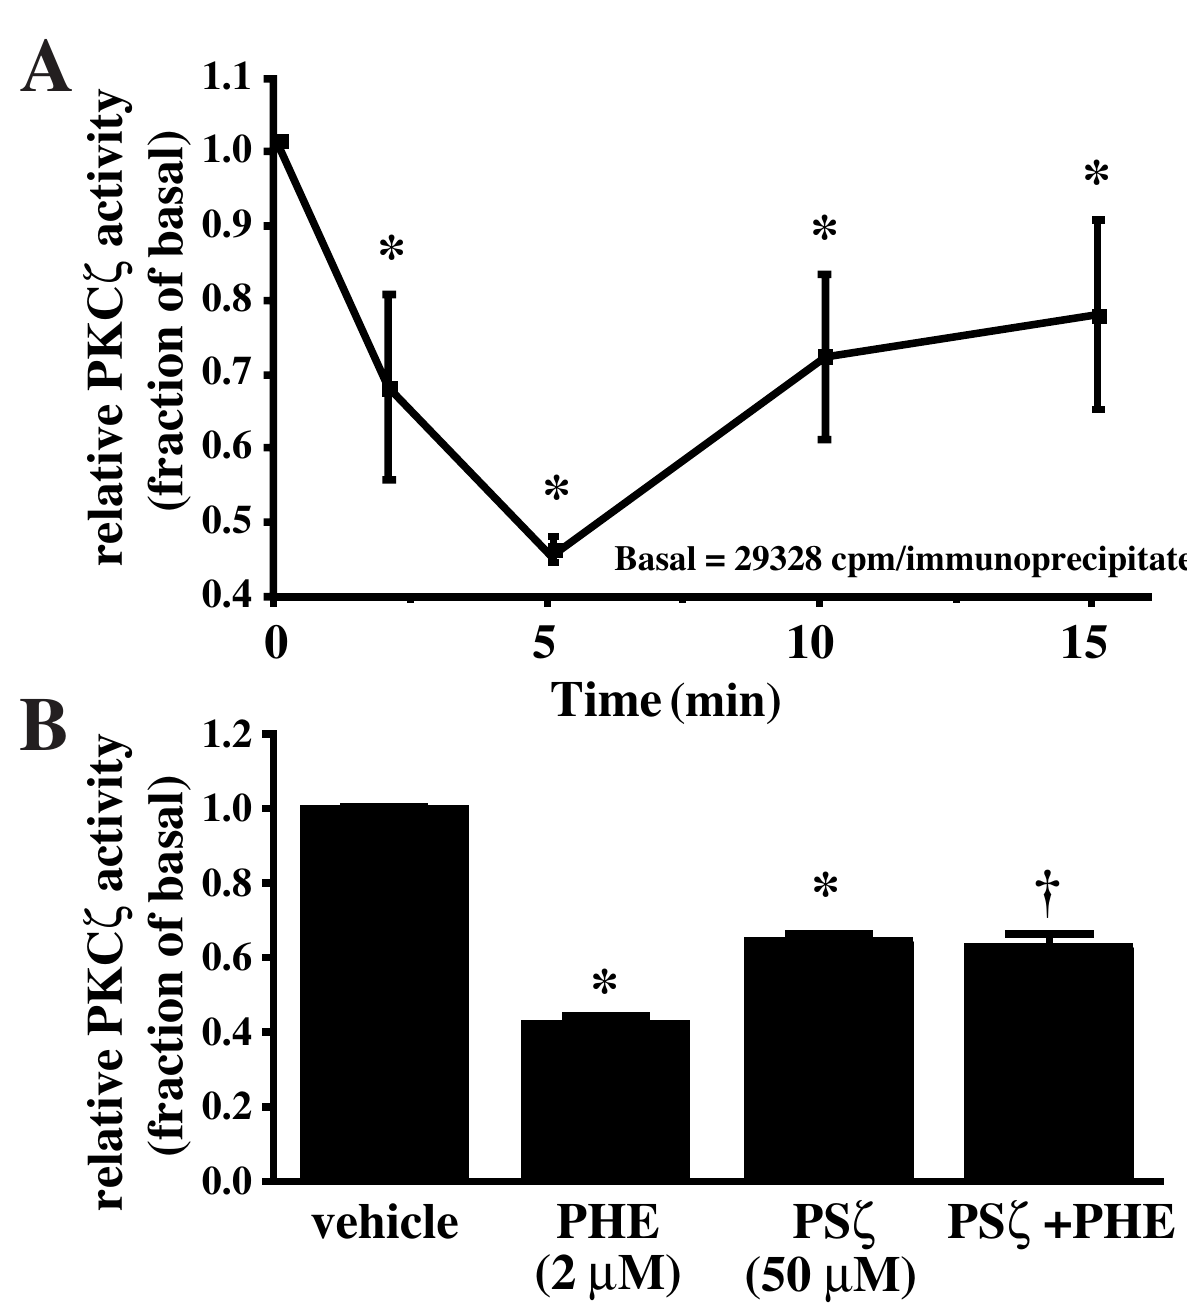
Figure 5 PHE decreases PKC ζ activity in rat-1 fibroblasts. A, Cells were treated with 2 µ M PHE for 0, 2, 5, 10 and 15 min, lysed and immunoprecipitated with PKC ζ antibody for a kinase assay using [ γ - 32 P]ATP and a selective peptide substrate as described in Methods. Relative PKC ζ activity was expressed as the fold (increase or decrease) of basal. Values are the mean ± S.E. of four independent experiments. * Value significantly different from the basal, p < .05. B, Effect of myristoylated PS ζ on PKC ζ activity. Cells were pretreated with 50 µ M PS ζ for 1 hour followed by a 5 min treatment with 2 µ M PHE or its vehicle. PKC ζ activity was measured as previously described. Values are the mean ± S.E. of four independent experiments. * Value significantly differ- ent from vehicle, p < .001. †, Value significantly different from PHE alone, p <